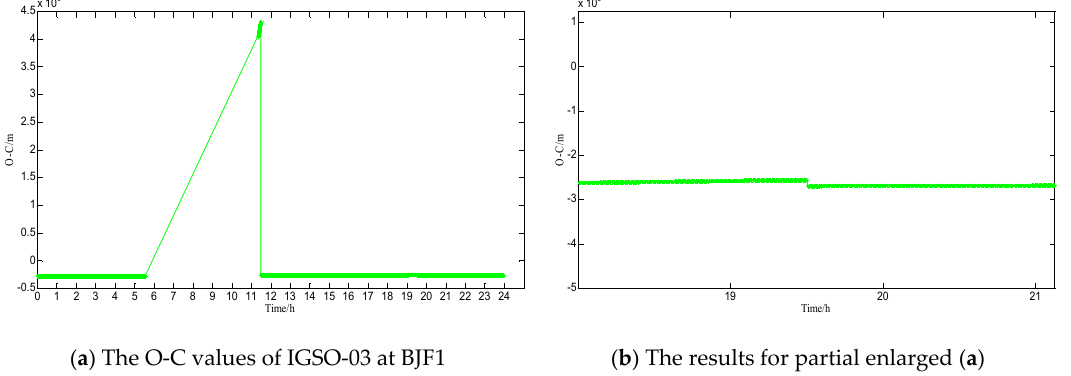
( a ) The O-C values of IGSO-03 at BJF1 ( b ) The results for partial enlarged ( a ) Figure 11. Results of O-C of IGSO-03 at BJF1 (The graph on the right is a partial enlarged view of the left).